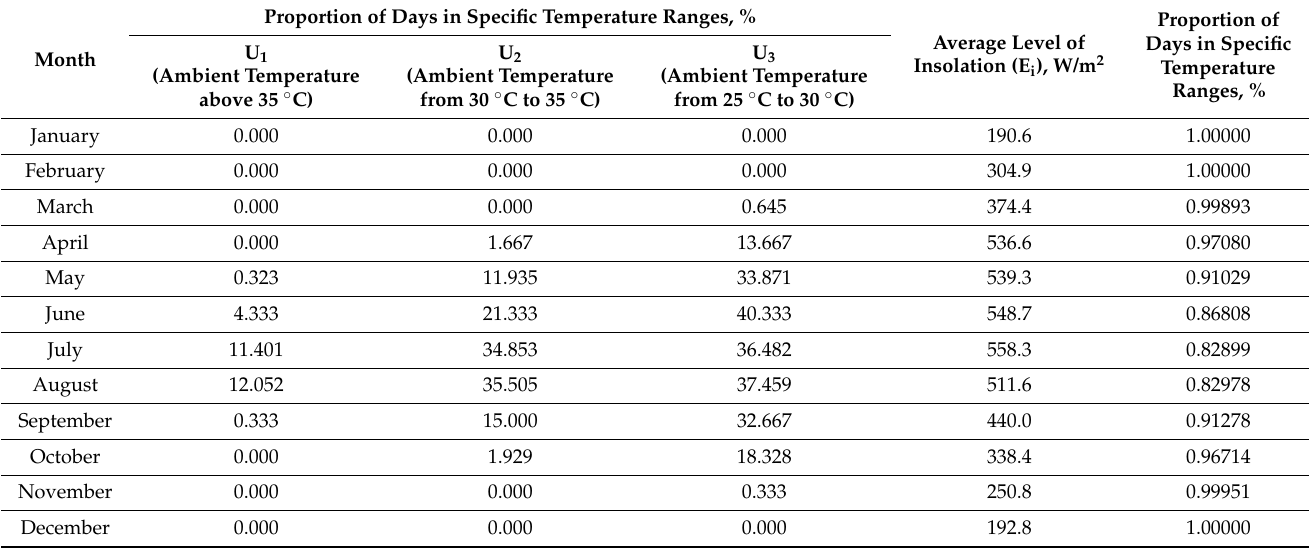
Table 2. Adjustment factor for the effect of temperature in each month with P max = 0.45.